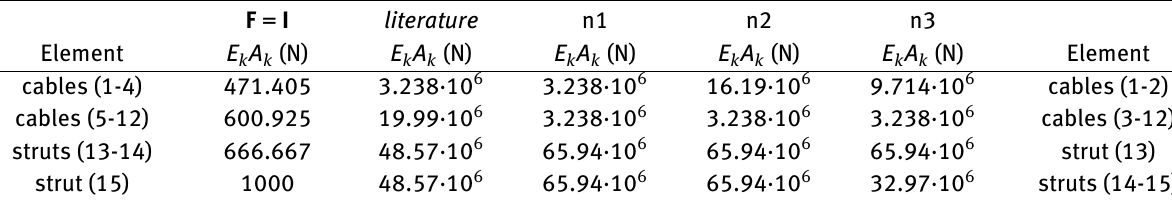
Table 7: Axial stiffness of the elements of the Octahedral cell